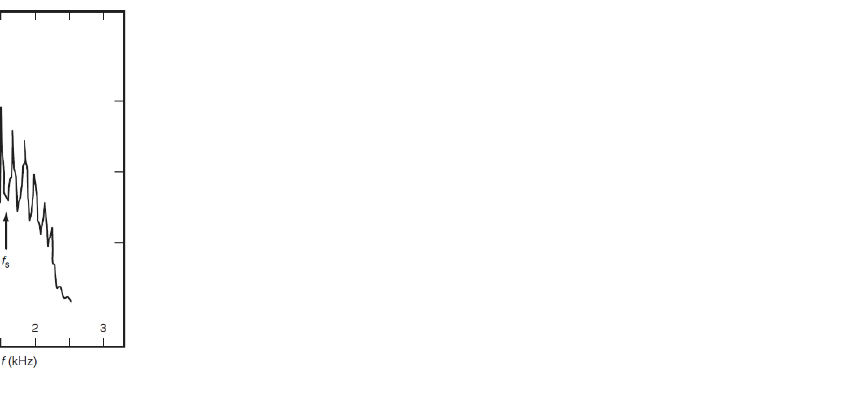
Figure 3. Airfoil frequency spectrum (adapted from Arbey and Bataille [10]).